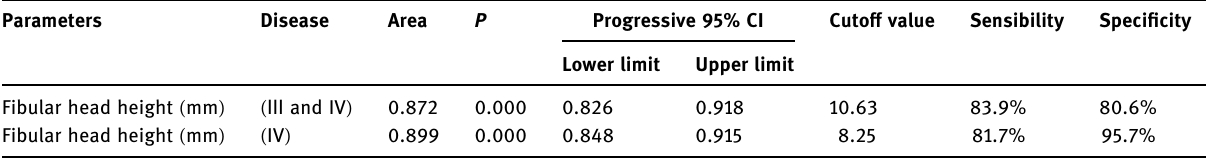
Table 4: ROC curve analysis Parameters